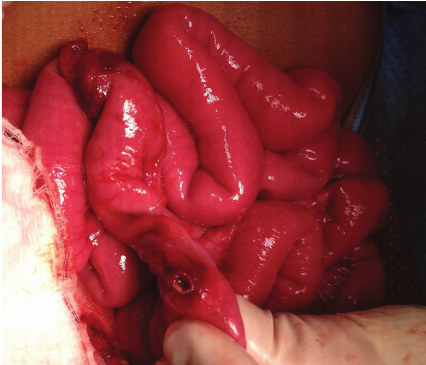
Figure 2: Operative findings of the same patient showing loops of jejunum, which were entrapped in between multiple rare-earth magnets resulting in pressure necrosis and bowel